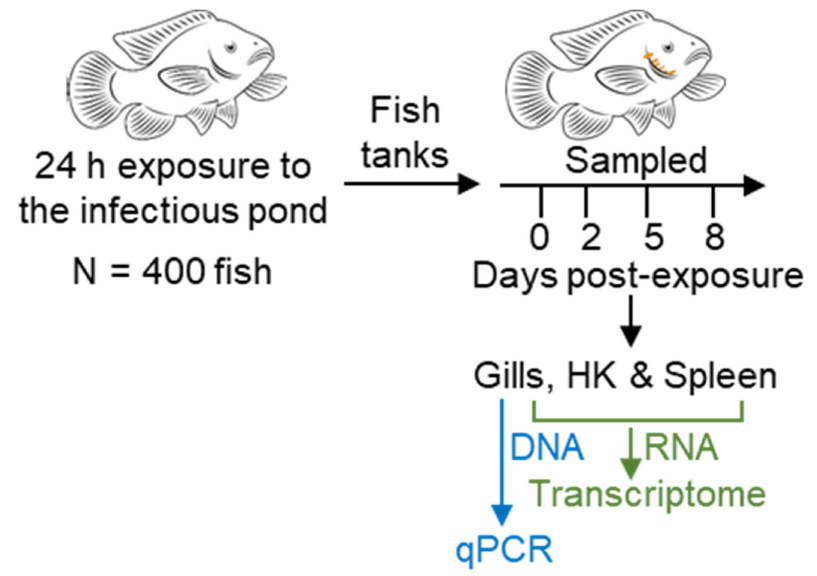
Figure 1. Experimental design. Approximately 400 3-month-old hybrid tilapia fish (Nile tilapia ( Oreochromis niloticus ) × blue tilapia ( O. aureus )) were introduced to an earthen pond at Reshafim Pisciculture, Beit She’an Valley, Israel, in four confined cages. After 24 h of exposure to the pond water, fish were translocated to 100-L indoor aquarium tanks in the Central Fish Health Laboratory, Nir David. Fish were sampled immediately and after 2, 5, and 8 days. To study M. bejeranoi infection intensity, DNA samples were extracted from gill tissue and to analyze host response, RNA samples were extracted from gill tissue and the immuno-organs HK and